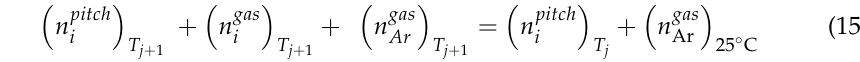
Figure 5. Hypothetical reactor design used to compute the mass and energy balances at every iteration in our model. Dashed line: border of the system, blue lines: mass flows; red lines: heat flows. Applying the mass conservation law over the system between 25–350 °C results in Equation (15 ‐ a):